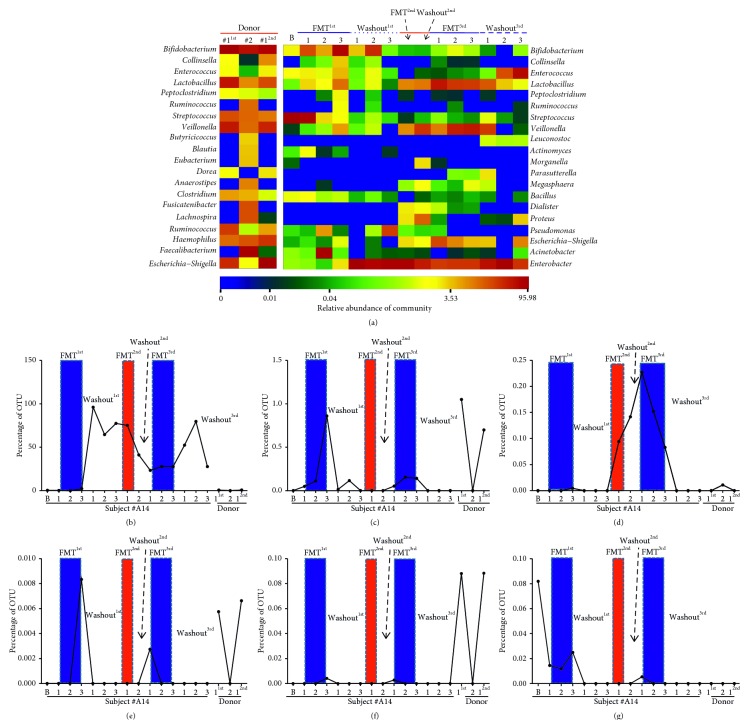
Dynamic changes in composition in the intestinal microbiota. (a) OTU heatmap of all the samples from both donors and the recipient during the entire FMT process. The thermal analysis shows the top 20 OTUs based on their relative abundances. The names on the left are the species annotations for each outlined OTU, and the color value of each square in each row indicates the relative abundance of that OTU. Dynamic changes in 6 OTUs were selected (b–g) from the 114 identified OTUs of patient #A19 based on their sensitivity to FMT.